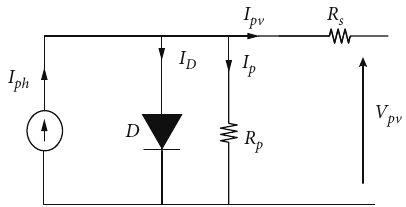
Figure 1: Single-diode equivalent circuit of the